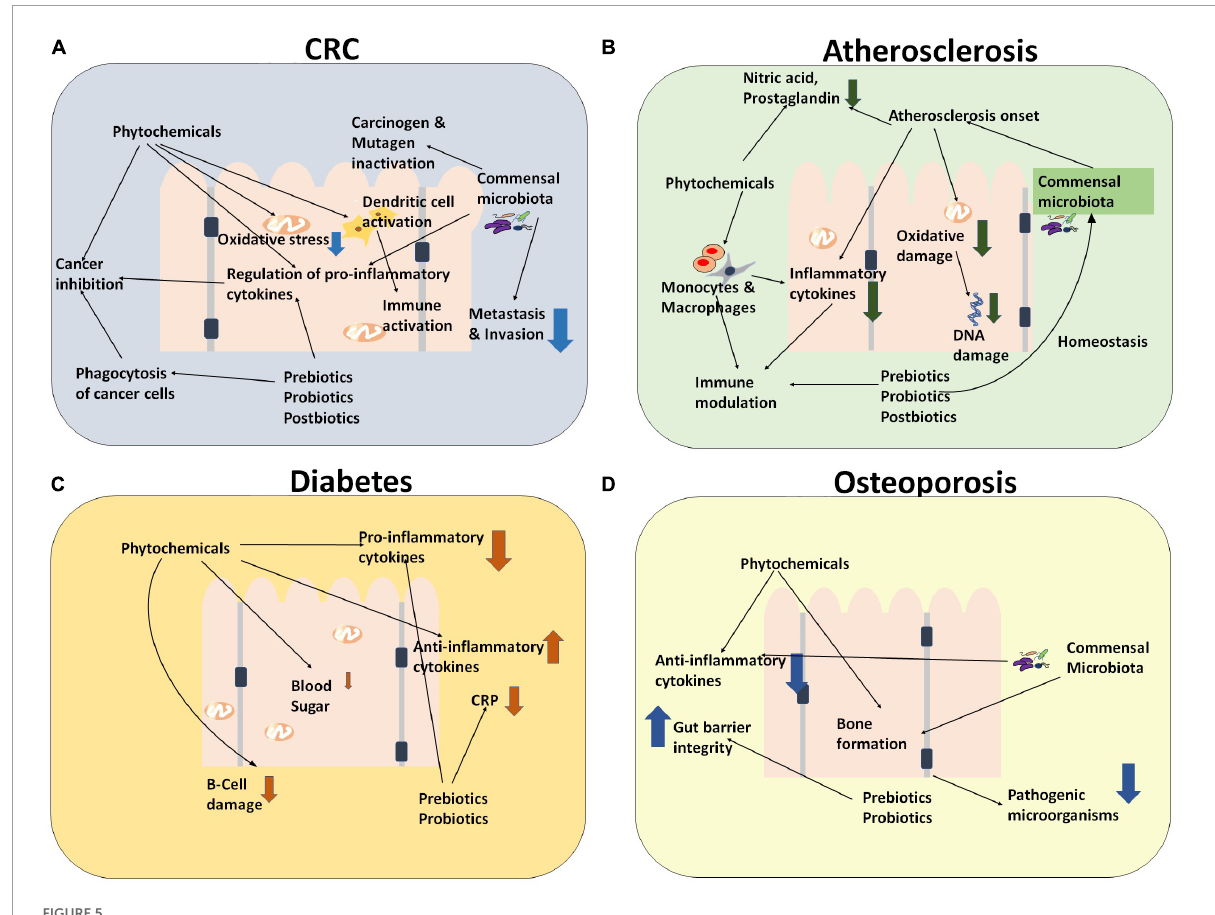
FIGURE5 Diagrammatic representation for the immunomodulatory role of various nutraceuticals (such as prebiotics, probiotics, and phytochemicals) wherein they exert a combinatorial effect through several pathways toward the management of (A) CRC and NCDs [such as (B) Atherosclerosis, (C) diabetes, and (D)